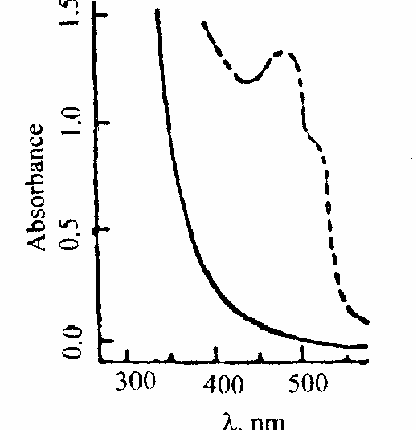
Figure 3. Absorption spectrum of 3,4,5-trimethoxy N -(2-hydroxybenzylidene) aniline at room temperature (---) and in liquid nitrogen ( ─